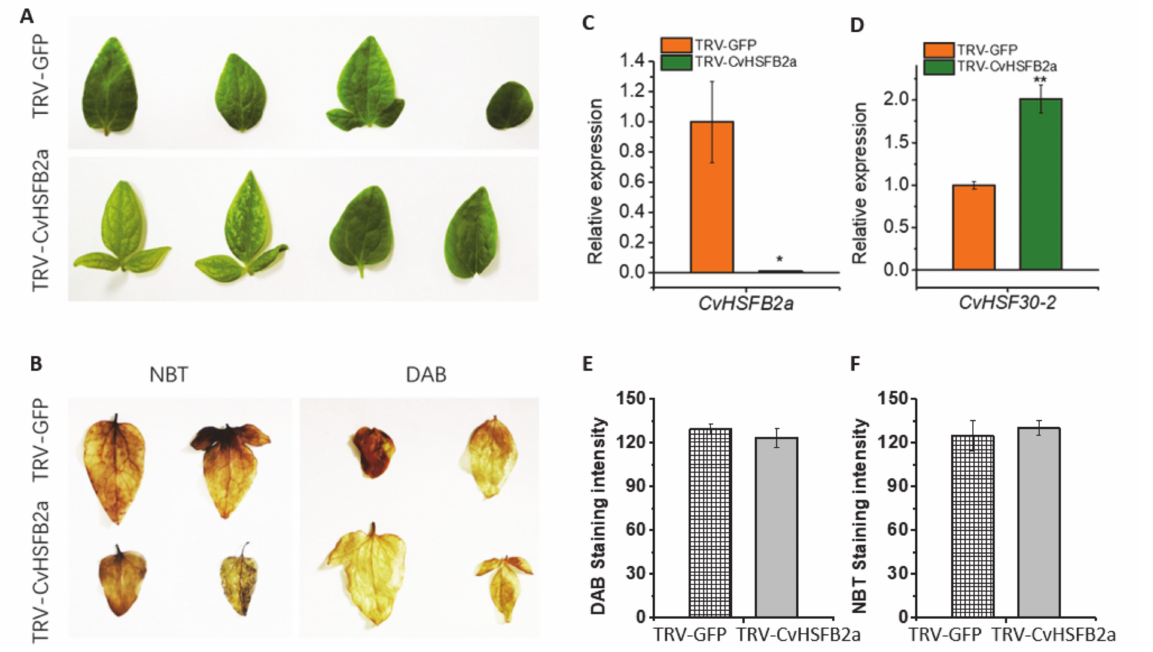
Figure 7. Silencing of CvHSFB2a in Clematis . ( A ) Phenotype of CvHSFB2a -silenced Clematis under heat treatment. ( B ) DAB and NBT staining of TRV-GFP and TRV-CvHSFB2a Clematis before and after heat treatment. ( C ) Silencing effect of CvHSFB2a. ( D ) The expression of CvHSF30-2 in TRV-CvHSFB2a plants. ( E , F ) DAB and NBT staining as quantified using the ImageJ2x program. Error bars represent the standard error of three biological replicates. * p < 0.05; ** p <